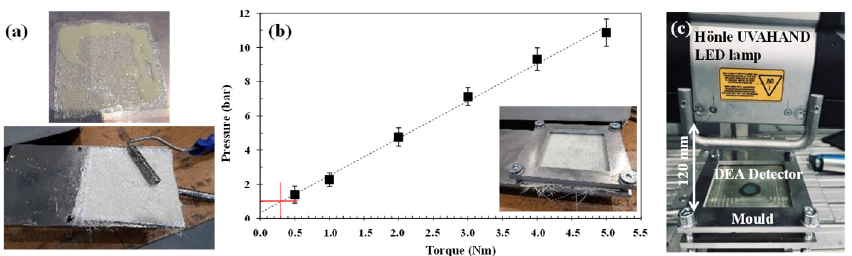
Figure 1. ( a ) Prepregs and composite manufacturing stages; ( b ) pressure applied in the final composite vs. the torque used to grip the tool. The standard deviation of the three samples is represented by the error bars. ( c ) Experimental DEA curing setup.